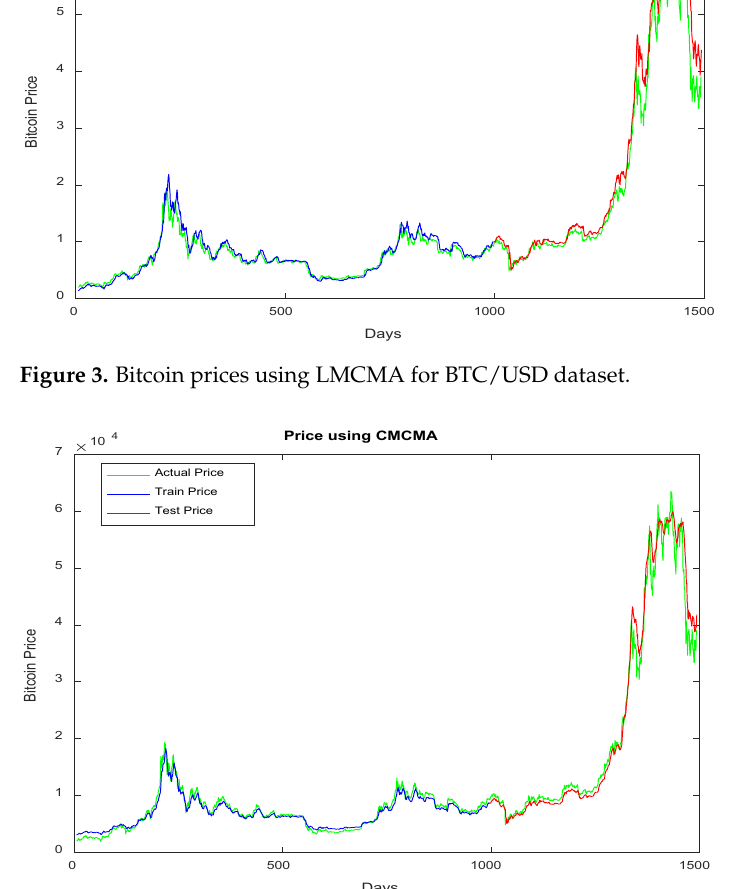
Figure 6. Bitcoin prices using CABCMA for BTC/EUR dataset. Figures 7 and 8 show the actual price, the corresponding training and the testing prices generated by the CMCMA and LMCMA models, respectively, for the BTC/JPY dataset. Again, the CMCMA and LMCMA model approximate Bitcoin prices with very few intervals of over-prediction and under-prediction.